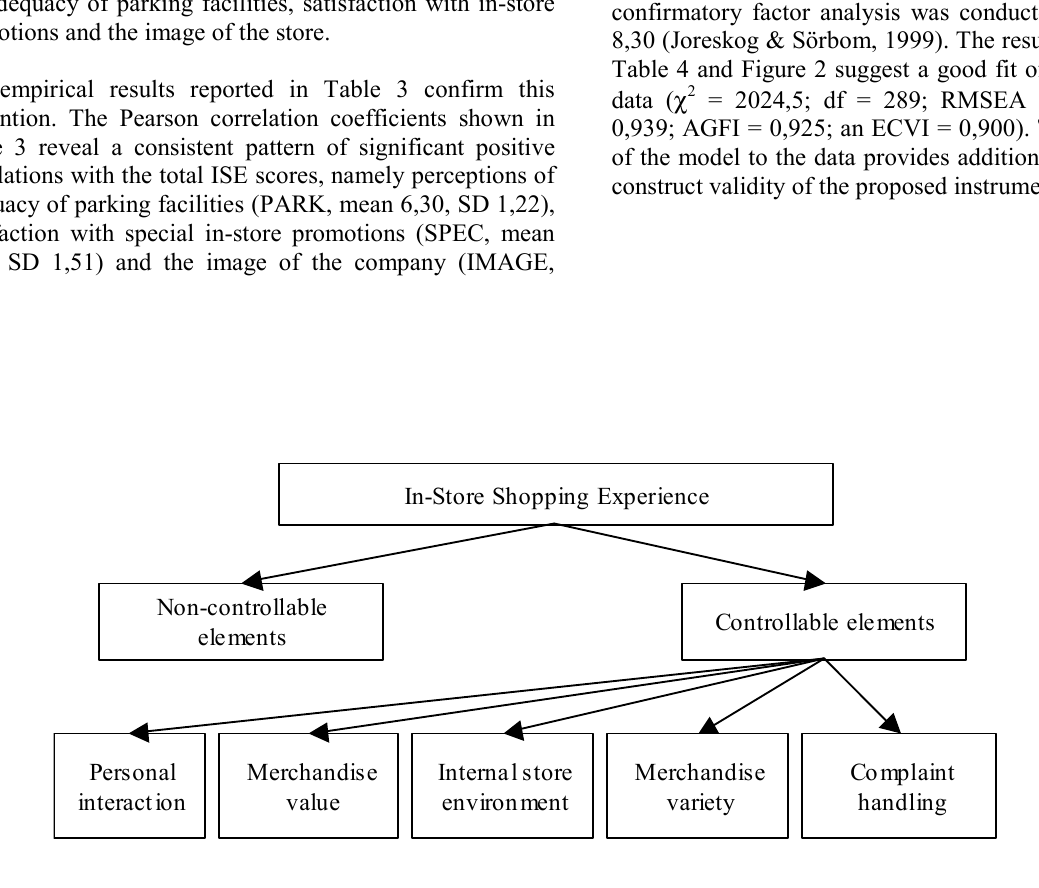
Figure 2: Empirical results of Survey